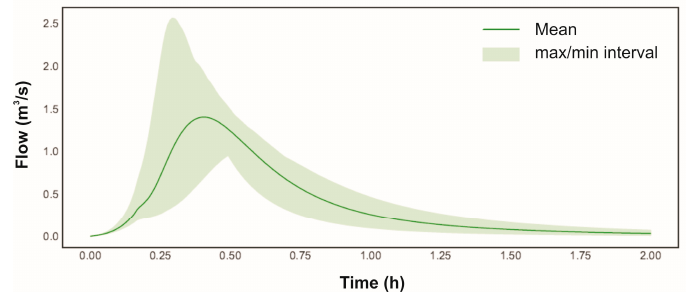
Figure 5. Interval which encloses the derived 100 UHs (training data set).